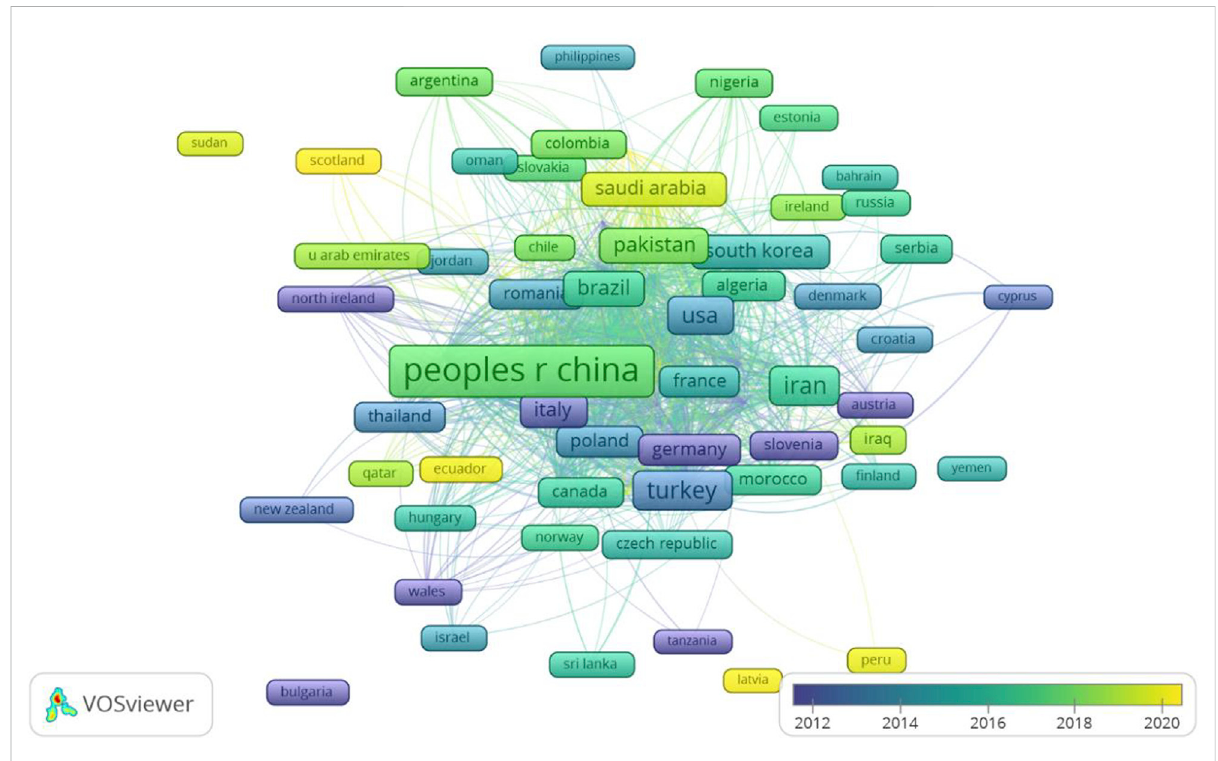
FIGURE 11 Countries linkage based on citations.